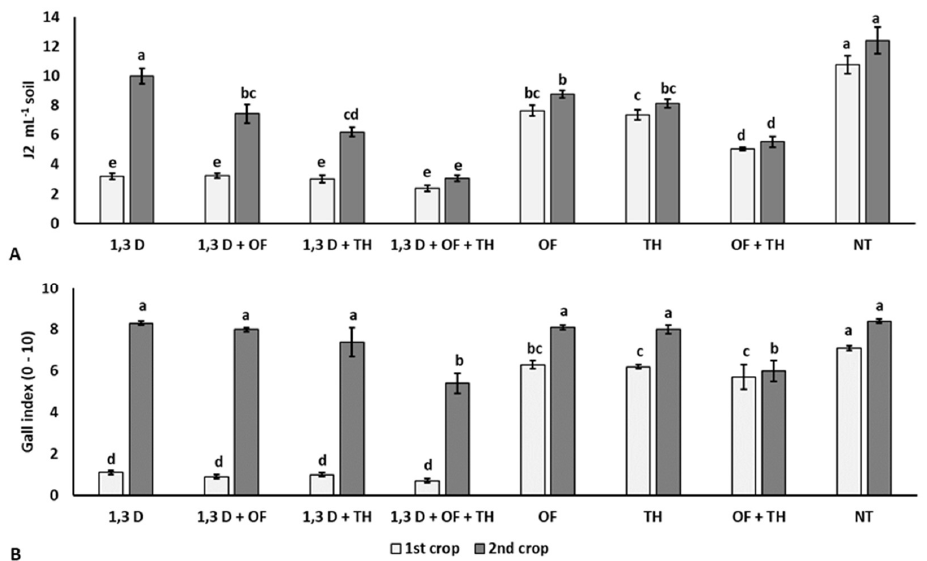
Figure 1. Effects of soil treatments with 1,3-dichloropropene (1,3-D), Trichoderma harzianum (TH) and an organic fertilizer (OF), either alone or in combination, on final population density ( A ) and root gall infestation ( B ) of Meloidogyne incognita in two consecutive tomato crops. NT = non-treated control. Bars show the average of n = 4 replicates of each treatment ± standard error. Within each tomato crop, bars marked by the same letters are not significantly different, according to the least significant difference test ( p ≤ 0.05).